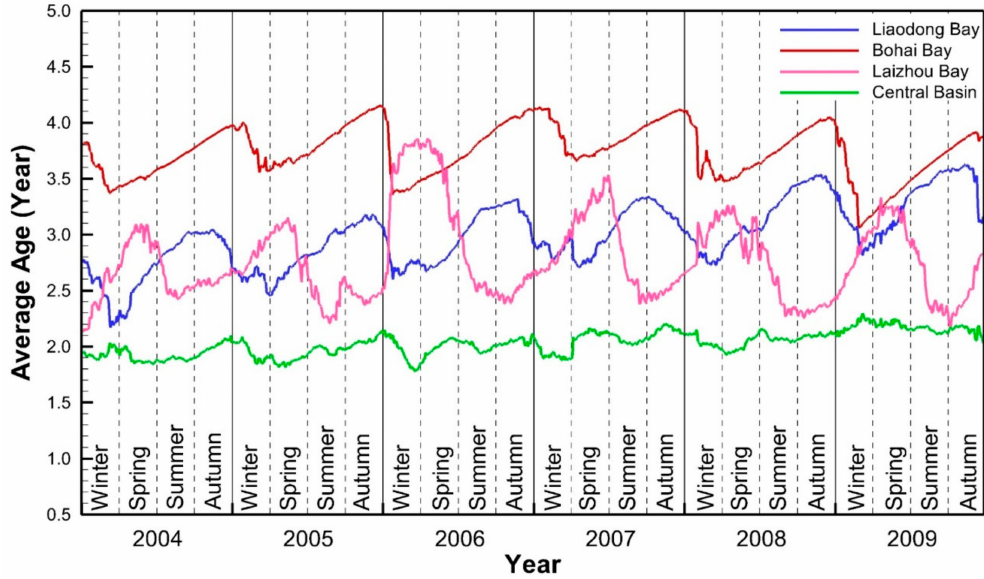
Figure 7. Volume-averaged age in the four parts of the Bohai